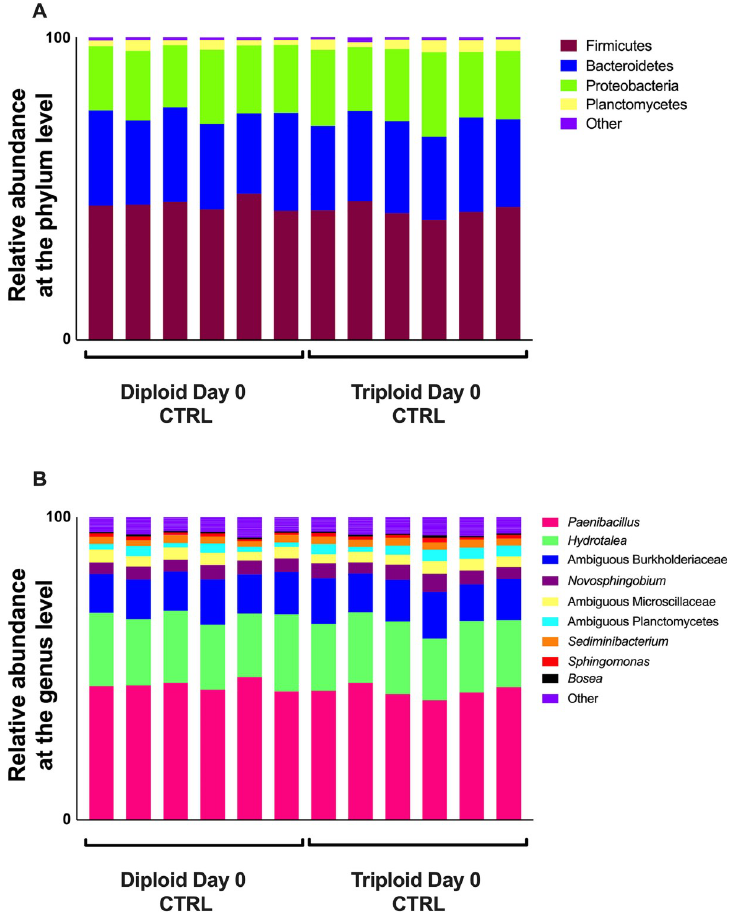
Fig 1. Microbial composition in the skin of triploid and diploid Atlantic salmon at the steady state. (A) Relative abundance at the phylum level for triploid and diploid skin at day 0. (B) Relative abundance at the genus level for triploid and diploid skin at day